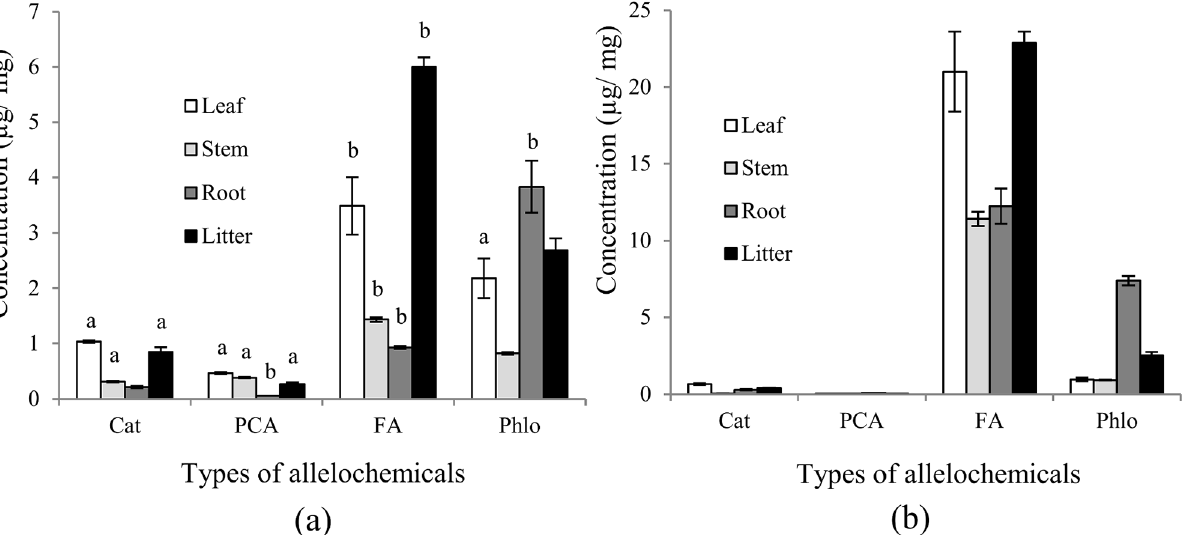
Fig 1. Concentrations of phenolic compounds in boneseed ((a) methanol extract and (b) water extract). The x-axis denotes the types of phenolic compounds e.g., catechin (Cat), p-coumaric acid (PCA), ferulic acid (FA) and phloridzin (Phlo). Values on y-axis denote the concentration of phenolic compounds in boneseed organs in μ g/ mg. White, light ash, deep ash and black colours (filled) in the columns represent leaf, stem, root and litter extracts respectively. The error bar indicates the standard error. The letters a and b above the columns depict the significant increase and decrease of phenolics in methanol extract respectively compared with water extract while columns without letters indicate non-significant